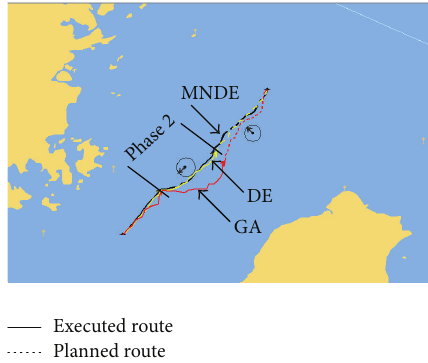
Figure 4: The solution space of the Rastrigin function.